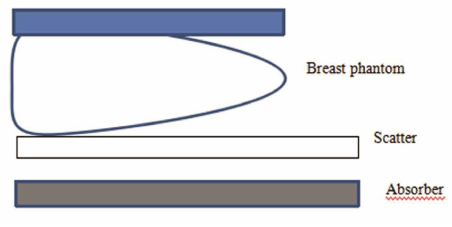
Fig. 1. Single-head Compton